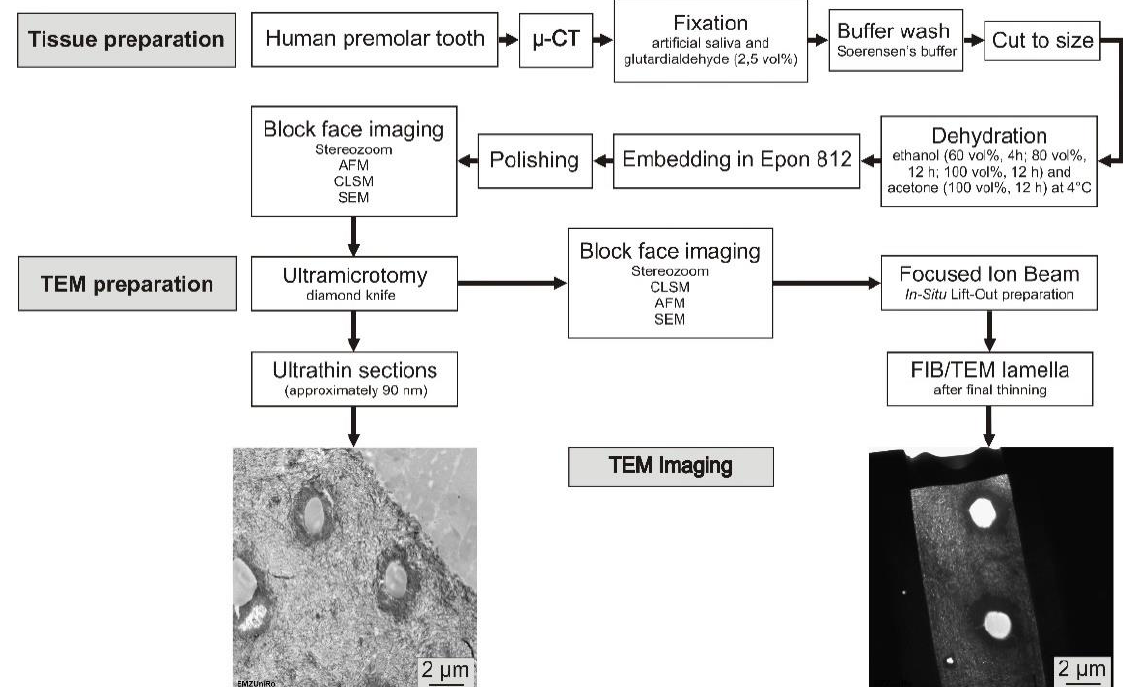
Figure 2. Experimental workflow of human mineralized enamel and dentine preparation using ultramicrotomy and in situ FIB lift-out technique for TEM imaging. For inspection and quality control in tissue preparation, multimicroscopic imaging was used (Stereozoom, AFM, CLSM, SEM).